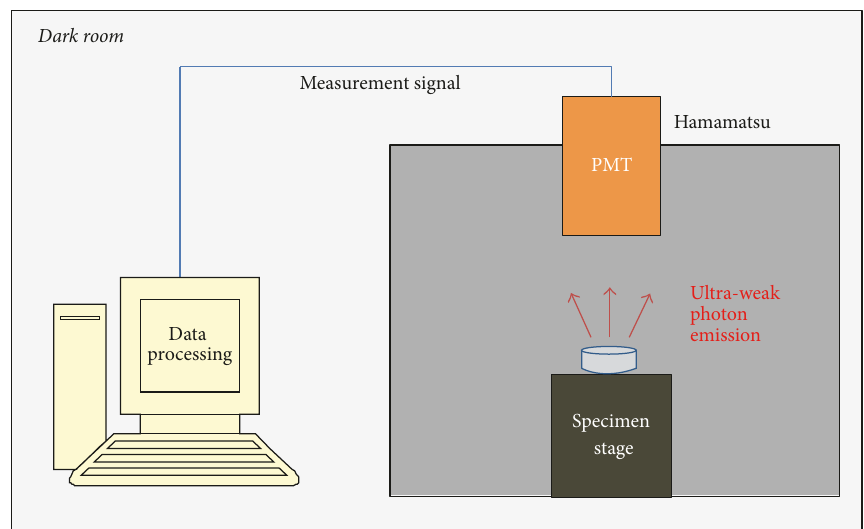
Figure 1: Schematic diagram of the ultra-weak photon emission measurement system.